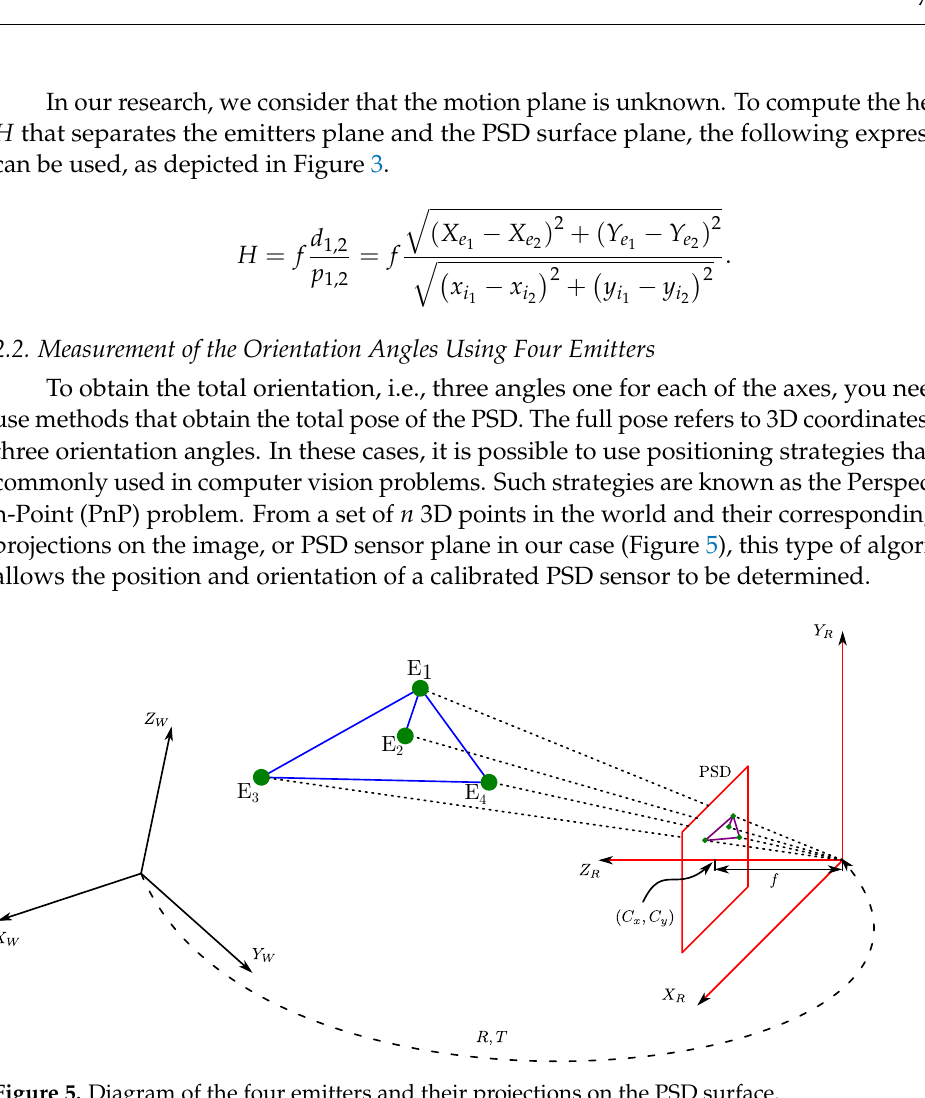
Figure 5. Diagram of the four emitters and their projections on the PSD